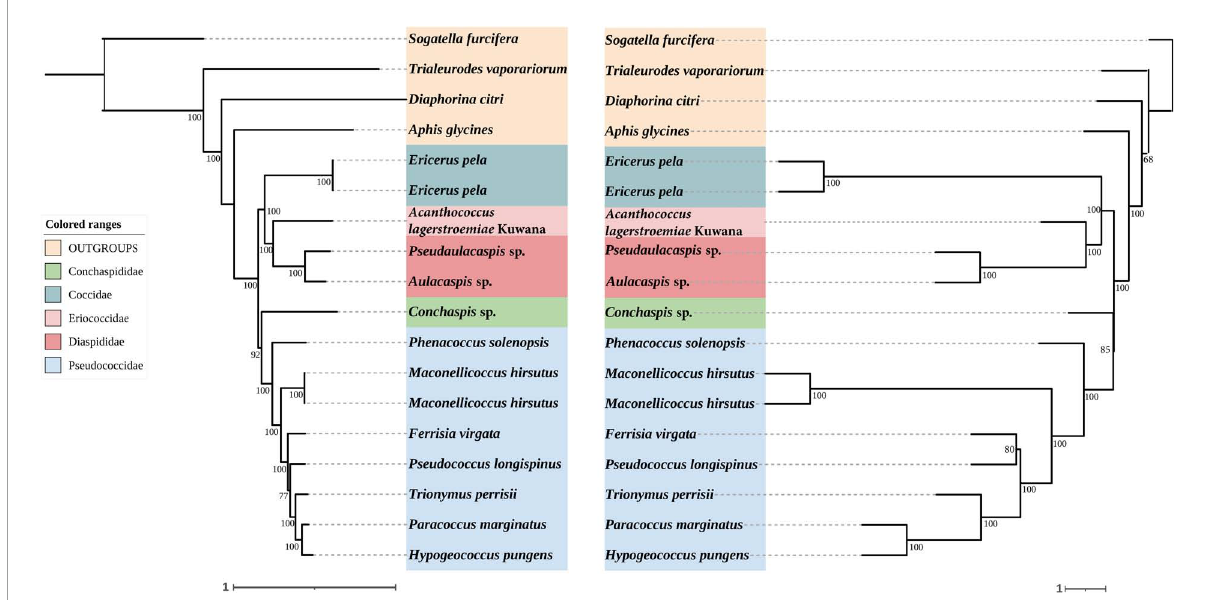
FIGURE3 Left: Concatenated tree of 85% completeness matrices from Coccoidea probe set. Node values are bootstrap support. Right: Species tree of 85% completeness matrices from Coccoidea probe set. Node values are bootstrap support.